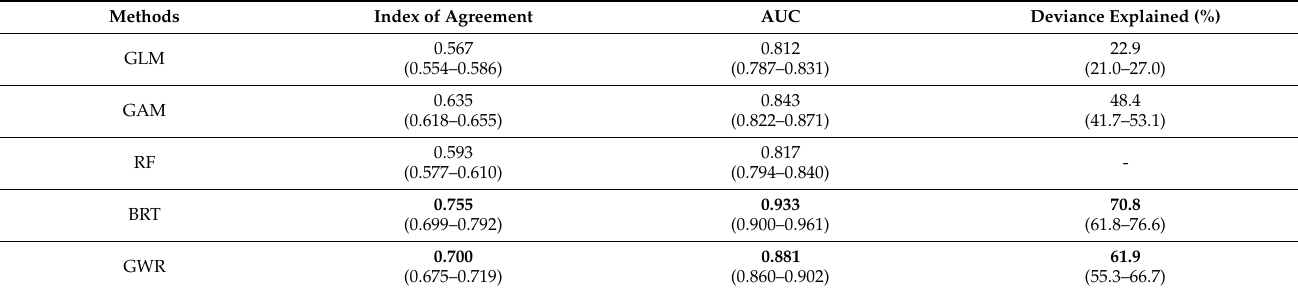
Table 3. Mean model performances using three criteria: mean index of agreement (Wilmott’s D test), mean AUC and mean percentage of deviance explained calculated for each of the five techniques (GLM, GAM, RF, BRT, GWR). Between brackets, the lowest and highest value obtained in the ten models with each method. In bold, the two best-classified methods in each